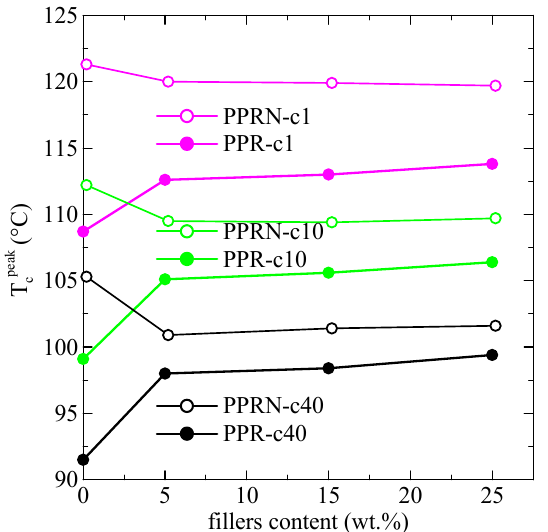
Figure 7. Variations in the peak crystallization temperature with the filler content (DSF and Millad) for the three indicated cooling rates, cx, with x in °C/min.